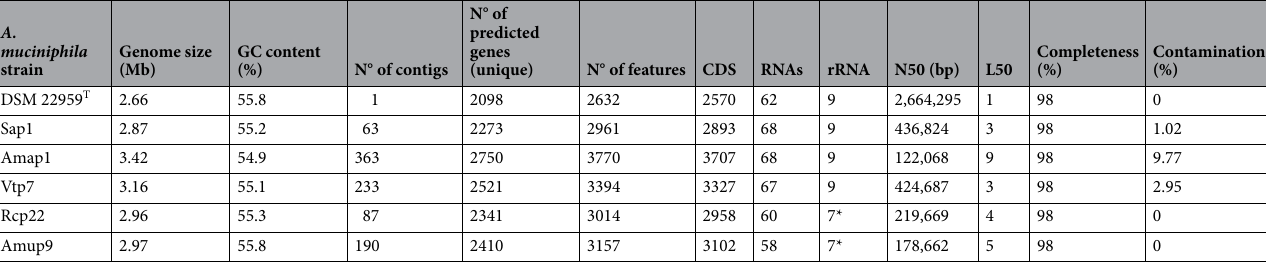
Table 1. General genomic features of A. muciniphila strains. CDS Coding sequences. *The discrepancy between the number of rRNA genes in strains Rcp22 and Amup9 compared to the reference DSM 22959 T and the other strains is likely due to the draft genome sequence. Specifically, two 16S rRNA genes and two 5S rRNA genes are missing in strains Amup9 and Rcp22 strains,